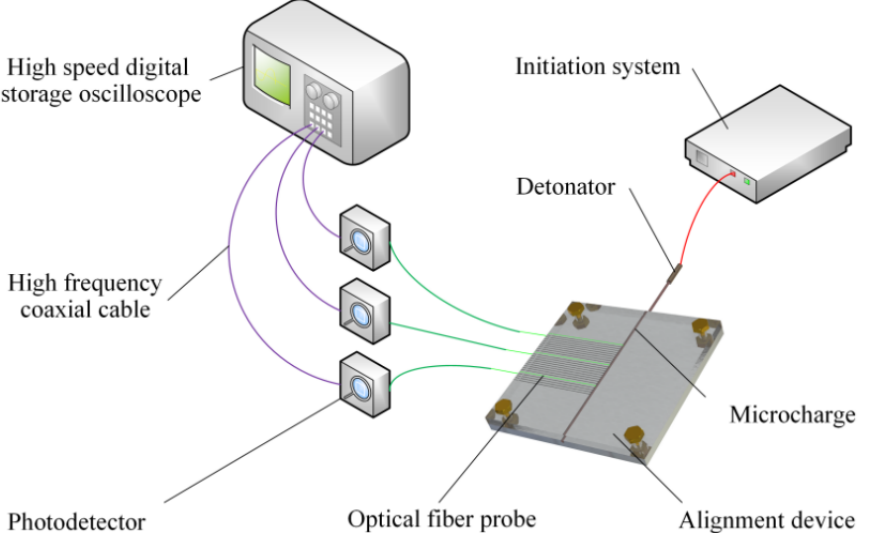
Figure 1. Schematic diagram of the experimental apparatus.